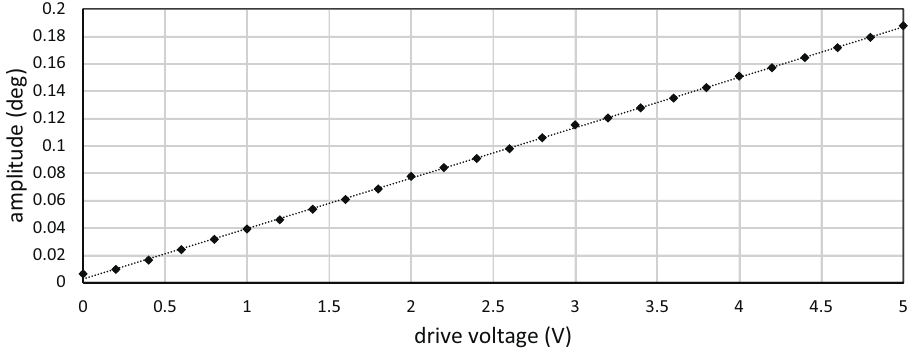
Figure 9. Relationship between drive voltage and vibration